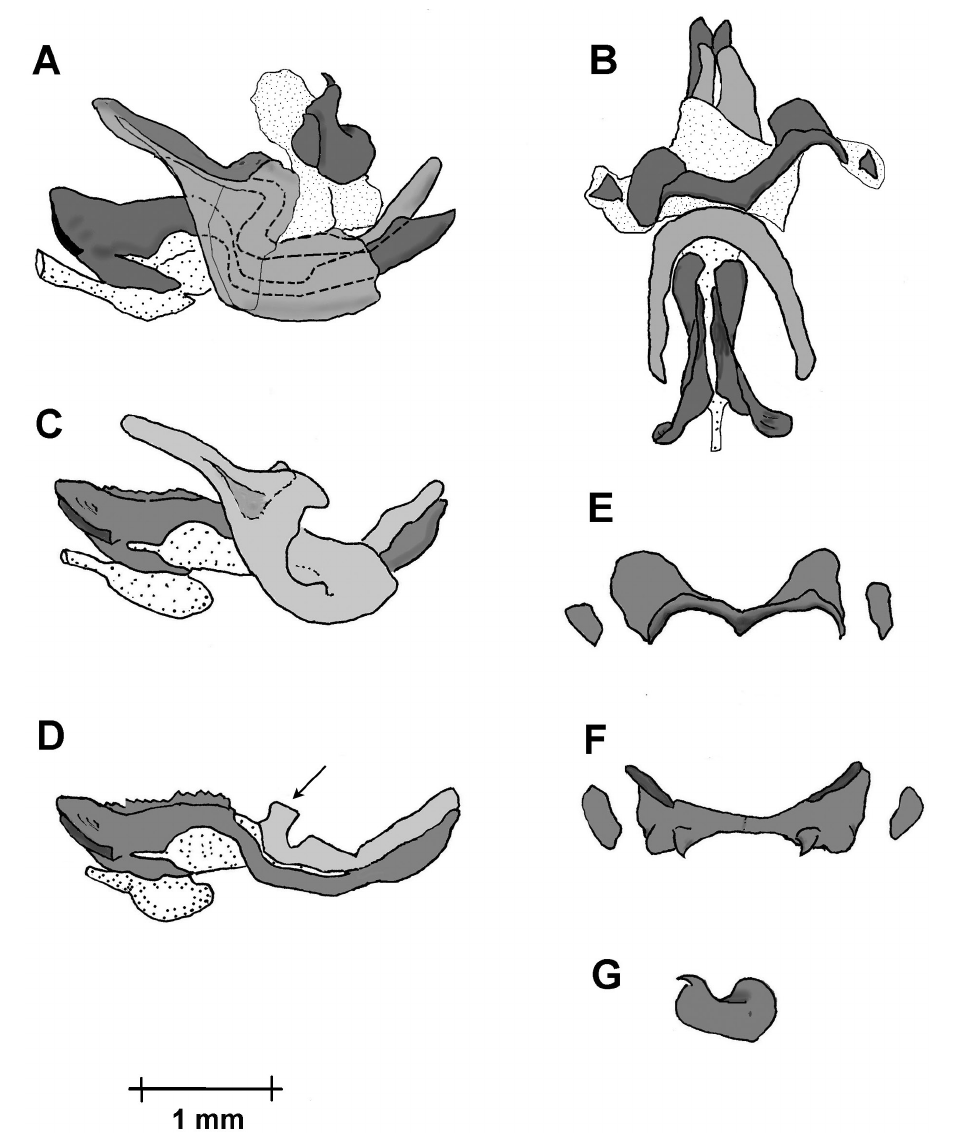
Fig. 9. Duviardia vansomereni (comb. n.), phallus. A. Entire phallic complex, lateral view. Fine stippling indicates remaining portions of the epiphallic membrane; B. As in A, but dorsal view. The epiphallus is twisted out of its normal position in this preparation; C. As in A, but entire epiphallic layer removed; D. As in C, but after removal of ectophallic cingulum and rami, showing endophallus and ectophallic arch. The arrow indicates the cut edge of the arch sclerite. E , F , G . Epiphallus in axial, dorsal and lateral